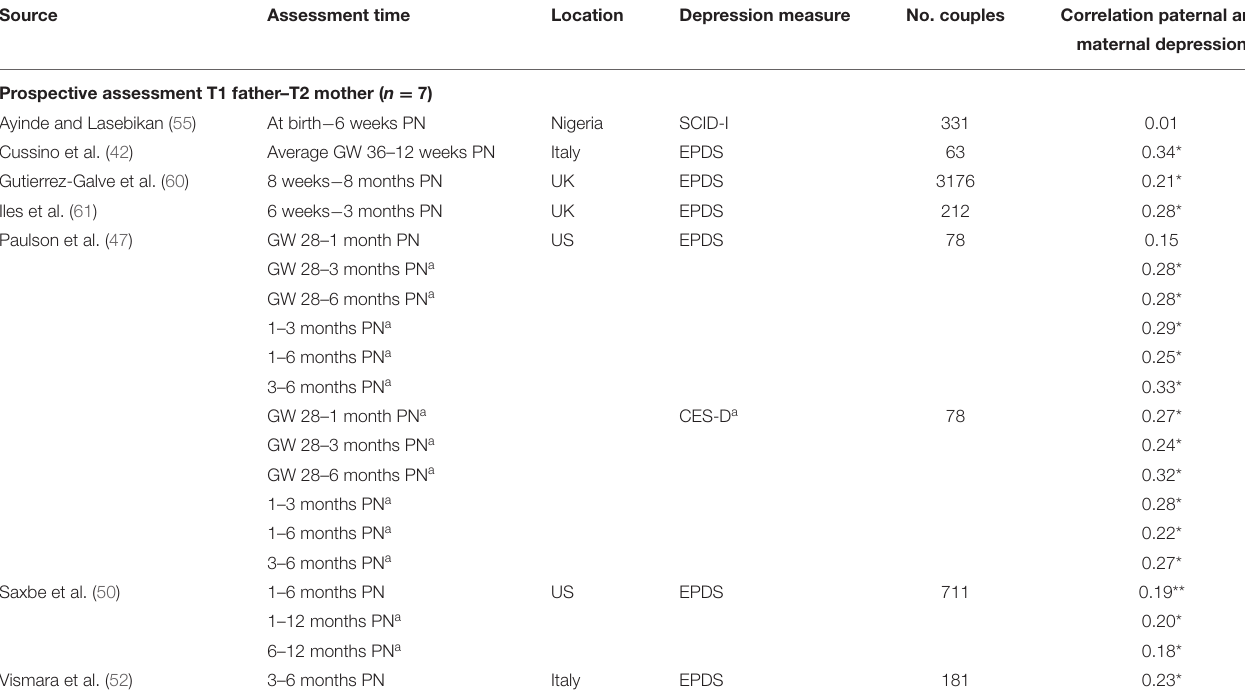
TABLE 1C | Characteristics of studies included in meta-analysis for the prospective association between paternal depression at one timepoint and maternal depression at a later timepoint.